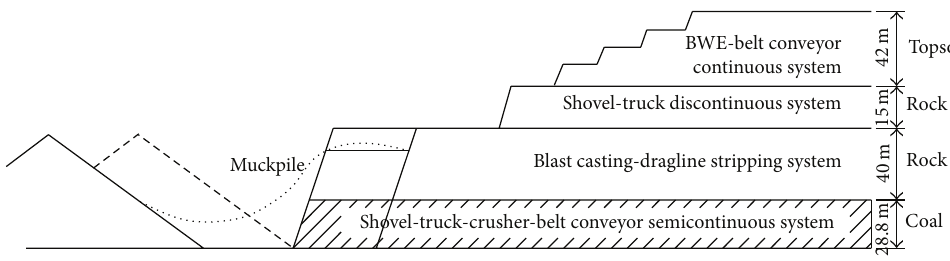
Figure 12: Mining technology systems of HSCM.